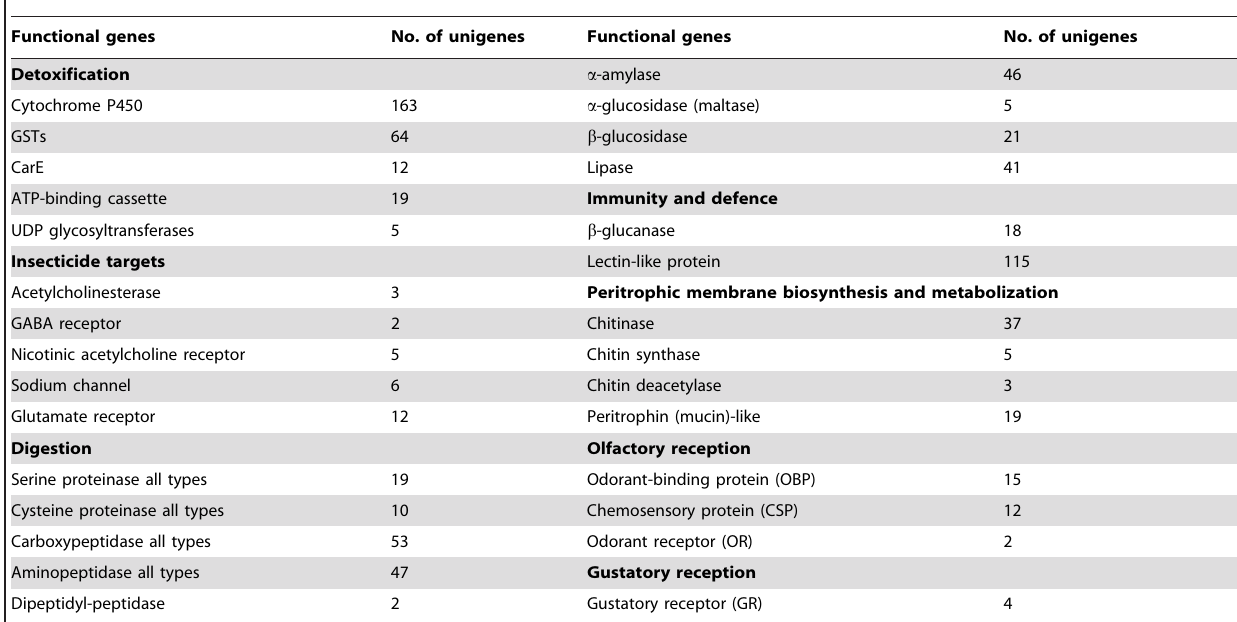
Table 3. Genes related to important physiological functions.